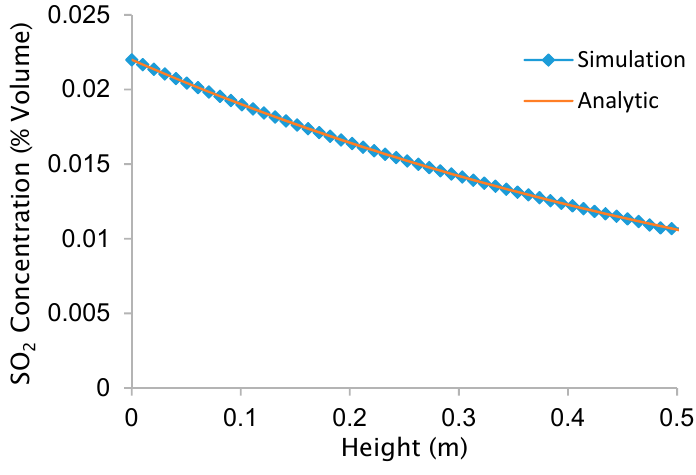
Figure 1. Verification of the computational model for fluidized bed hydrodynamics and a reaction term.